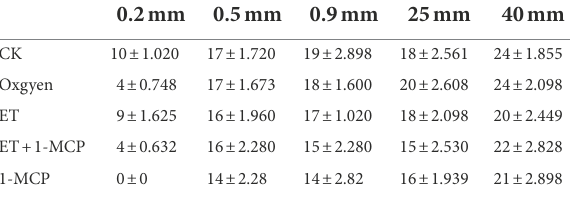
TABLE 2 Number of cavities in the first circle aerenchyma of Nelumbo nucifera